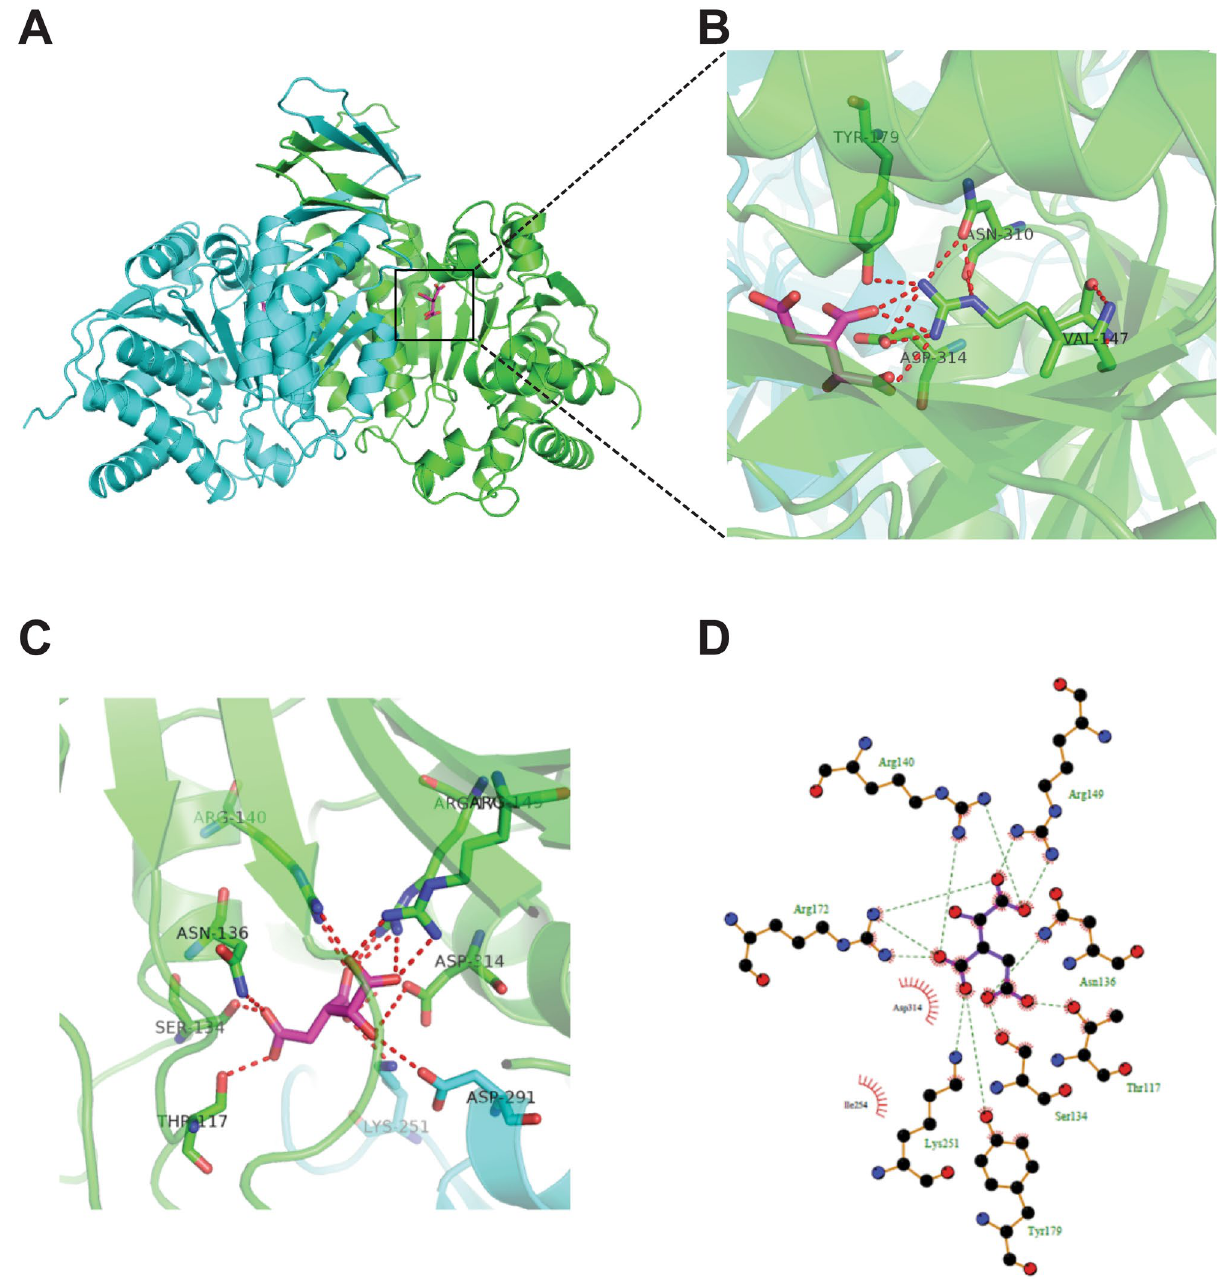
Figure 6. The effects of IDH2 mutations on the protein structure by bioinformation homology modeling. ( A ) Guided by the highly homologous PcIDH structure (PDB ID: 1LWD), a homology modeling structure of human wild-type IDH2 was constructed. ( B ) The interactions of R172 in the active site of human IDH2 and surrounding amino acids located on the surface of dimers were modeled, a dash line from ( A ) to ( B ), indicating the zooming part. The interactions of isocitrate and surrounding amino acids are shown. Hydrogen bonds (dashed line, C ) and hydrophobic bonds (eyelashes, D ) are